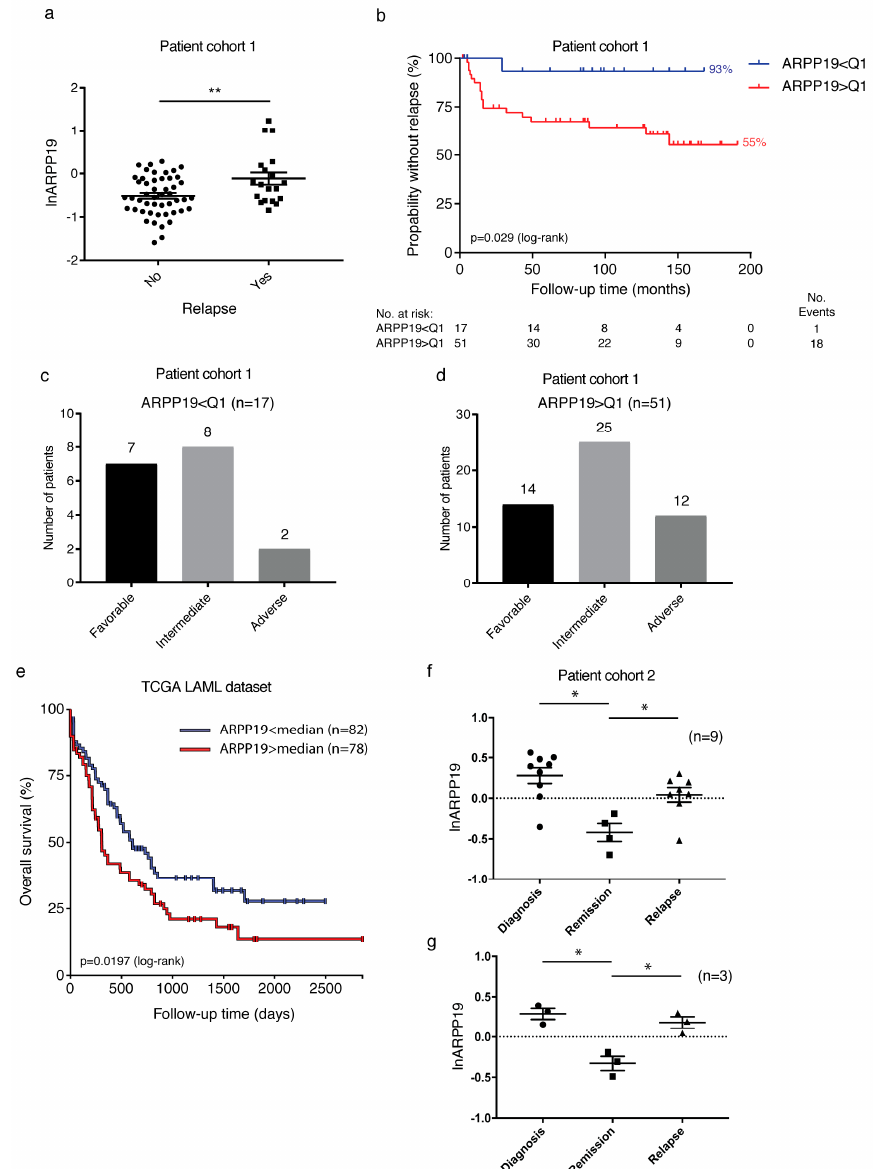
Figure 4. High ARPP19 mRNA expression is a risk group independent predictive relapse marker in AML. ( a ) Patients without relapse in cohort1 ( n = 49) during the follow-up time had lower diagnostic ARPP19 mRNA expression than patients with relapse ( n = 19). Shown is the logarithmic mean ± standard error of mean (SEM). ARPP19 expression in pooled ( n = 56) normal bone marrow sample is set as 0. **(no vs. yes relapse) p = 0.0046 by Student’s t -test. ( b ) Lower ARPP19 expression is associated with longer time to relapse (Kaplan–Meier estimate in months) in AML patients, p = 0.029 by log-rank test. Q 1 = lowest quartile of ARPP19 mRNA expression ( n = 17). ( c ) Patients in the lowest quartile ARPP19 mRNA expression are assigned to all risk groups. ( d ) Patients over the lowest quartile ARPP19 mRNA expression are assigned to all risk groups. ( e ) Kaplan–Meier survival curve for overall survival (OS) by ARPP19 gene expression (exon IlluminaHiSeq RNAseq) in TCGA acute myeloid leukemia (LAML) patients ( n = 160). Median serves as cut-off value. Lower ARPP19 expression is associated with longer OS in AML patients, p = 0.0197 by log-rank test. ( f ) ARPP19 mRNA expression in diagnosis ( n = 9), remission ( n = 4) and relapse ( n = 8) samples from patients with AML. ARPP19 expression in pooled ( n = 56) normal bone marrow sample is set as 0 (dashed line). Shown is logarithmic mean ± SEM. *(diagnosis vs. remission) p = 0.021, *(remission vs. relapse) p = 0.034 by paired t -test. ( g ) ARPP19 mRNA expression in matched diagnosis, remission and relapse samples from three patients with AML. *(diagnosis vs. remission) p = 0.047, *(remission vs. relapse) p = 0.034 by paired t